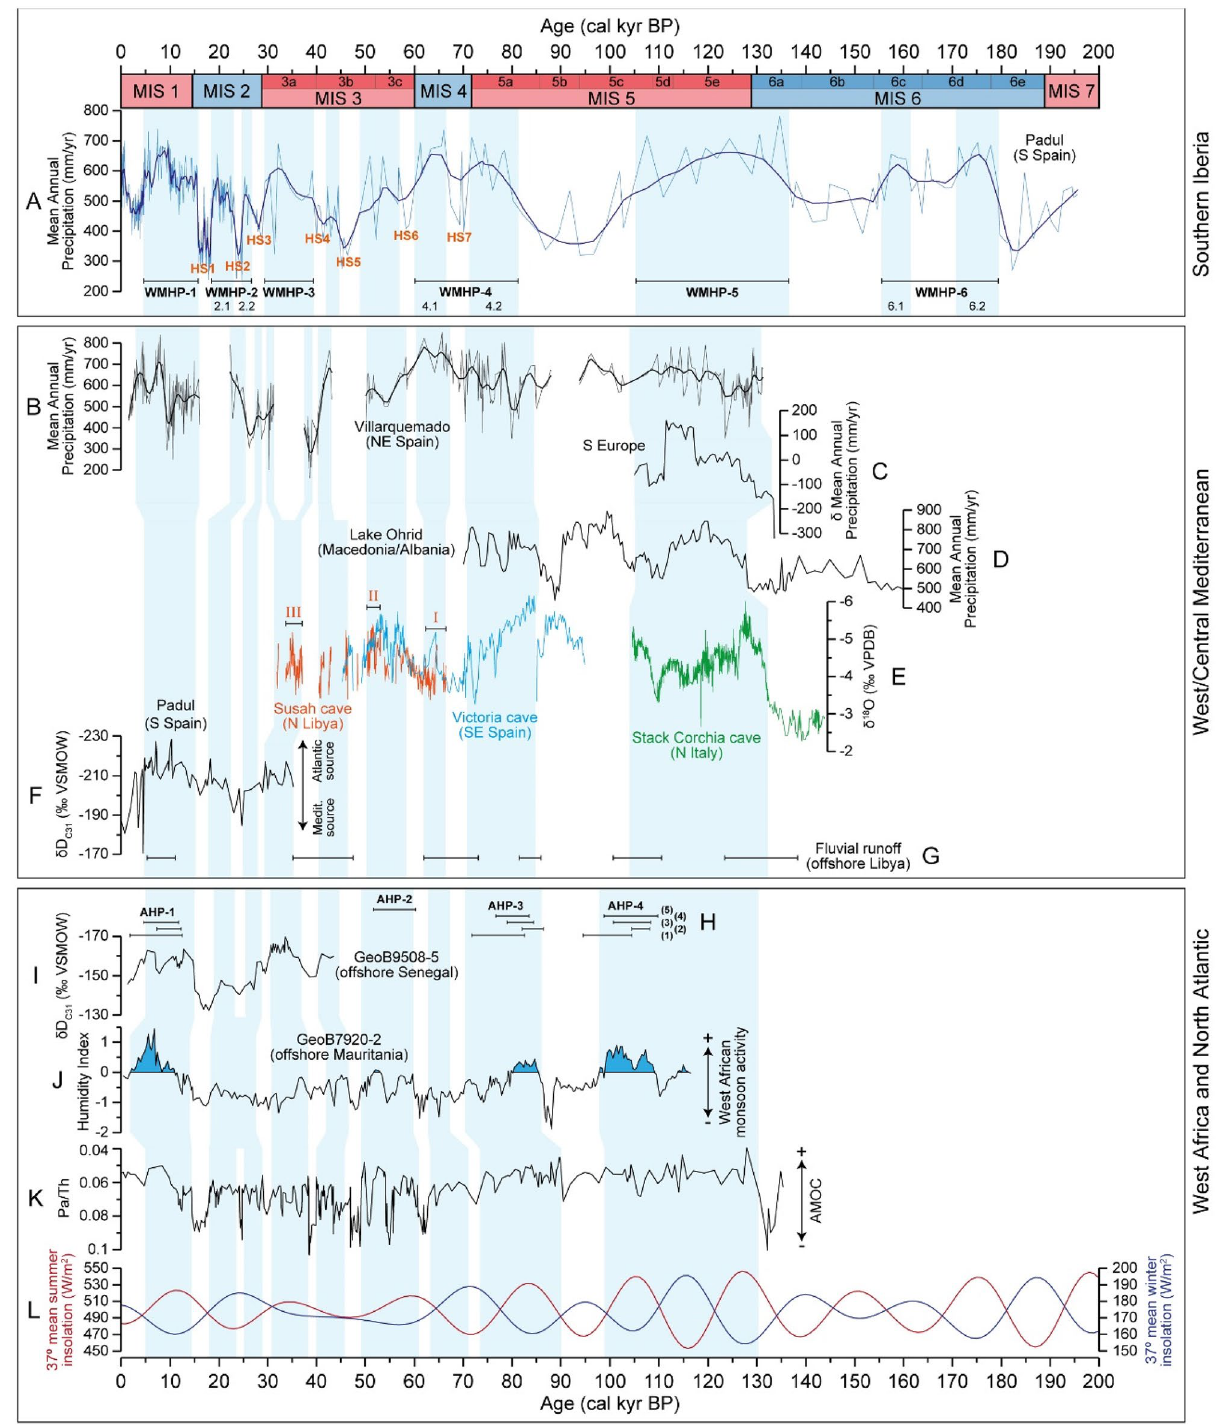
Figure 4. Comparison of the Padul MAP reconstruction with other multiproxy records for the last 200 kyr BP. Top panel (southern Iberia): ( A ) Reconstructed Padul MAP (mm/yr) along with the WMHPs (black horizontal lines) and HSs. Middle panel (other West/Central Mediterranean records): ( B ) our Villarquemado MAP reconstruction (mm/yr) (NE Spain), ( C ) Average MAP change (mm/yr) for southern Europe 40 , ( D ) MAP reconstruction from Lake Ohrid (Macedonia/Albania) 11 , ( E ) δ 18 O from Susah cave (N Libya) 2,46 , Victoria cave (SE Spain) 45 and Corchia cave (N Italy) 41–44 (note inverted scale), ( F ) δD C31 from Padul 31 (note inverted scale), ( G ) fluvial runoff pulses from the 64PE349-8 record (offshore Libya) 47 . Bottom panel (West Africa, North Atlantic and insolation): ( H ) age-ranges of African Humid Periods (black horizontal lines) identified by different studies: (1) Ehrmann et al. 96 , (2) Grant et al. 97 , (3) Skonieczny et al. 98 , (4) Ziegler et al. 99 and Pausata et al. 48 , and (5) Kinsley et al. 100 , ( I ) δD C31 from the GeoB9508-5 record (continental slope off Senegal) 51 (note inverted scale), ( J ) Humidity index from the GeoB7920-2 record (offshore Mauritania) 58 , ( K ) Pa/Th from the North Atlantic CDH19 record 61 (note inverted scale), ( L ) 37°N mean summer and winter